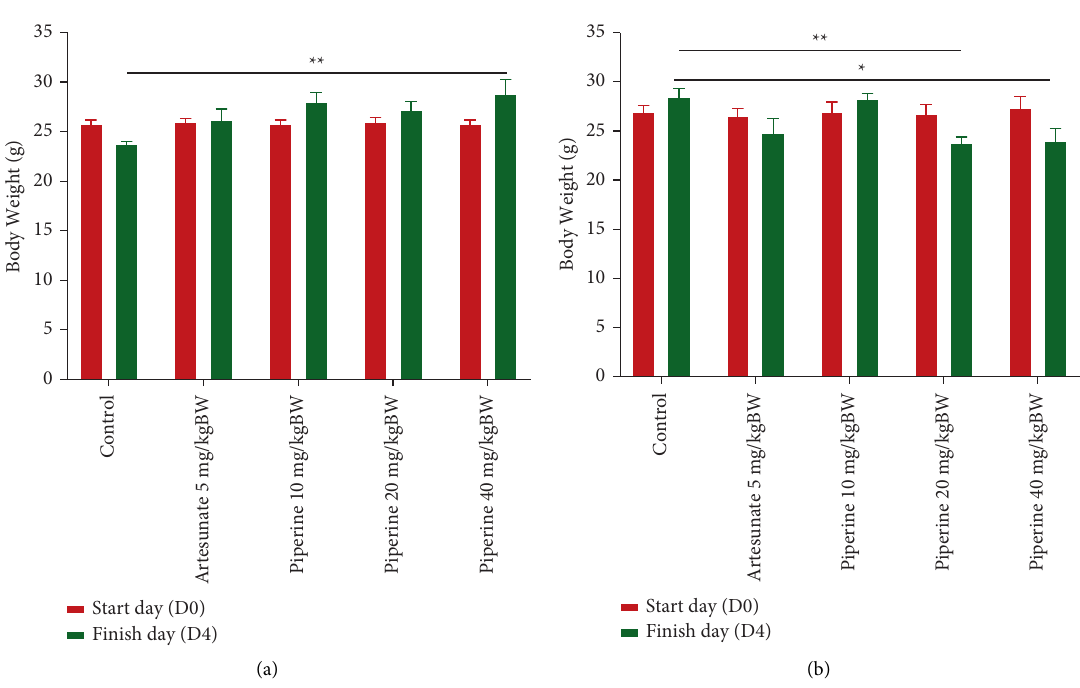
Figure 2: Effect of piperine administration on body weight of mice infected with P. berghei ANKA in the (a) curative test and (b) prophylactic test. Data are presented as mean ± SEM. ∗∗ p < 0 . 01; ∗ p < 0 . 05 compared with negative control (two-way ANOVA followed by Tukey’s post hoc test).